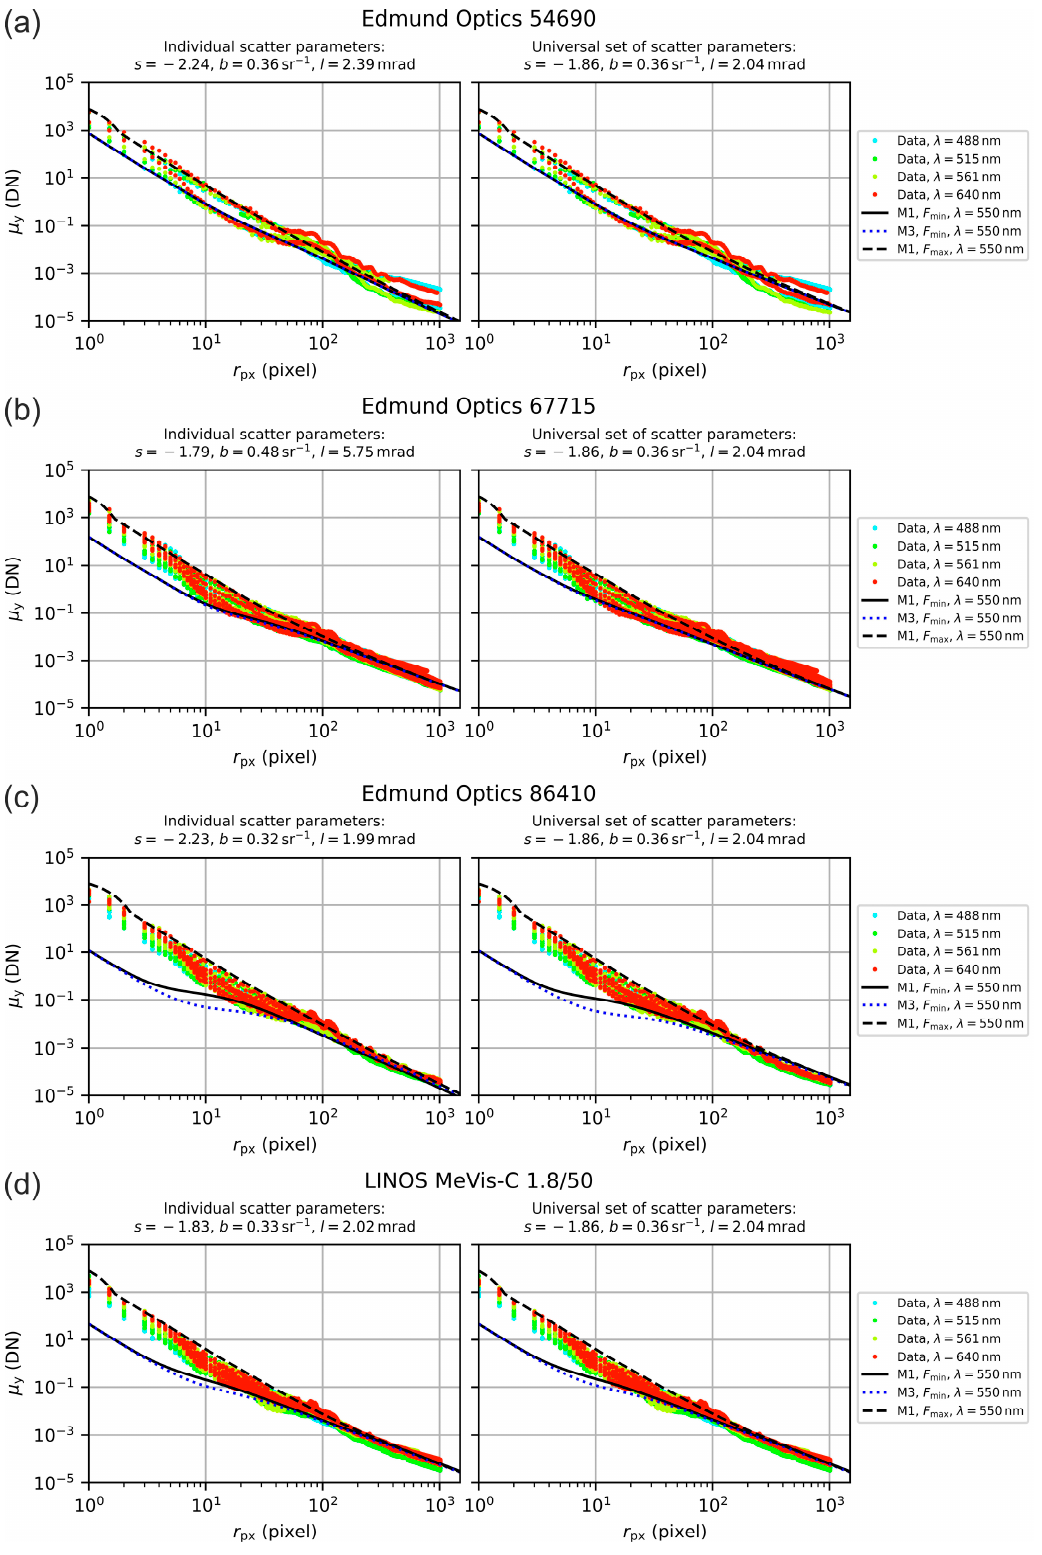
Figure 18. Comparison of measured irradiance profiles and predictions of the theoretical model M1. Calculations were performed both using the individual scatter parameters of the lens (graphs on the left hand side) and the generic set of scatter parameters (graphs on the right hand side). Lenses: ( a ) Edmund Optics 54690, ( b ) Edmund Optics 67715, ( c ) Edmund Optics 86410 and ( d ) LINOS MeVis-C 1.8 /